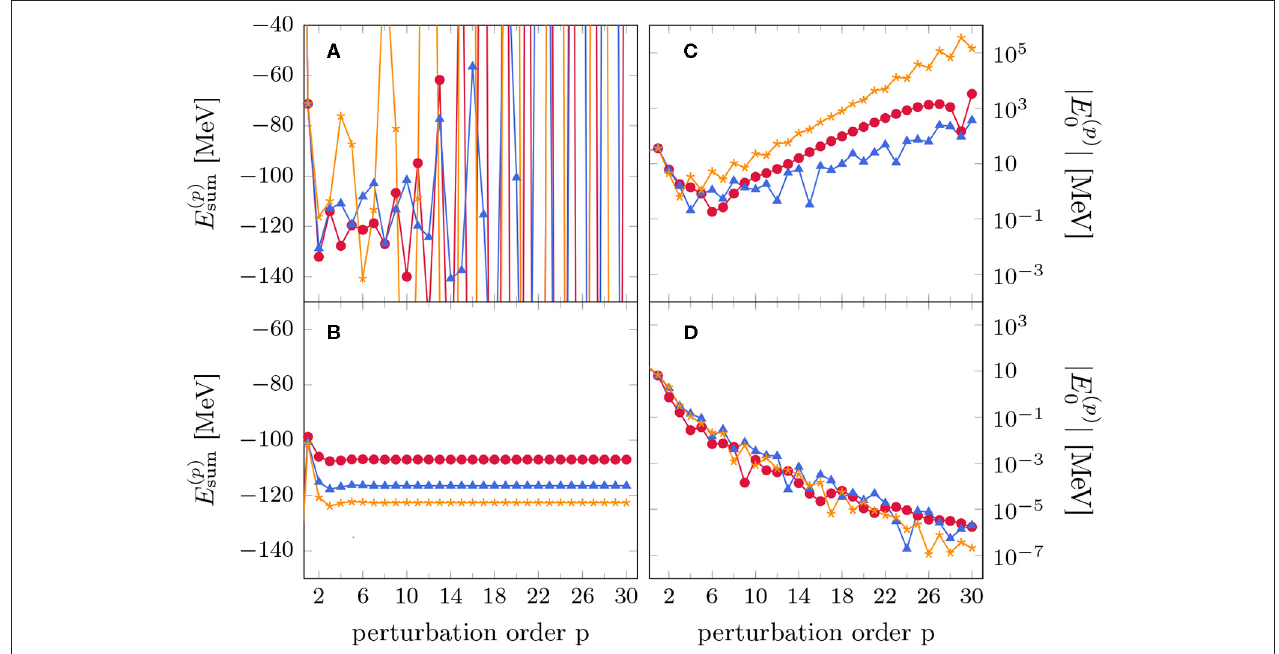
FIGURE 3 | Partial sums (A,B) and order-by-order corrections (C,D) for the ground-state energy of 16 O using the Hamiltonian described in section 3. Top (bottom) panels correspond to the HO (HF) partitioning. All calculations are performed using N max = 2,4,6 ( l , H , ⋆ ) and an oscillator frequency of ¯ h ω = 24MeV. The SRG parameter is set to α = 0.08fm 4 . Reproduced from Tichai et al. [ 34] under the Creative Commons CC-BY